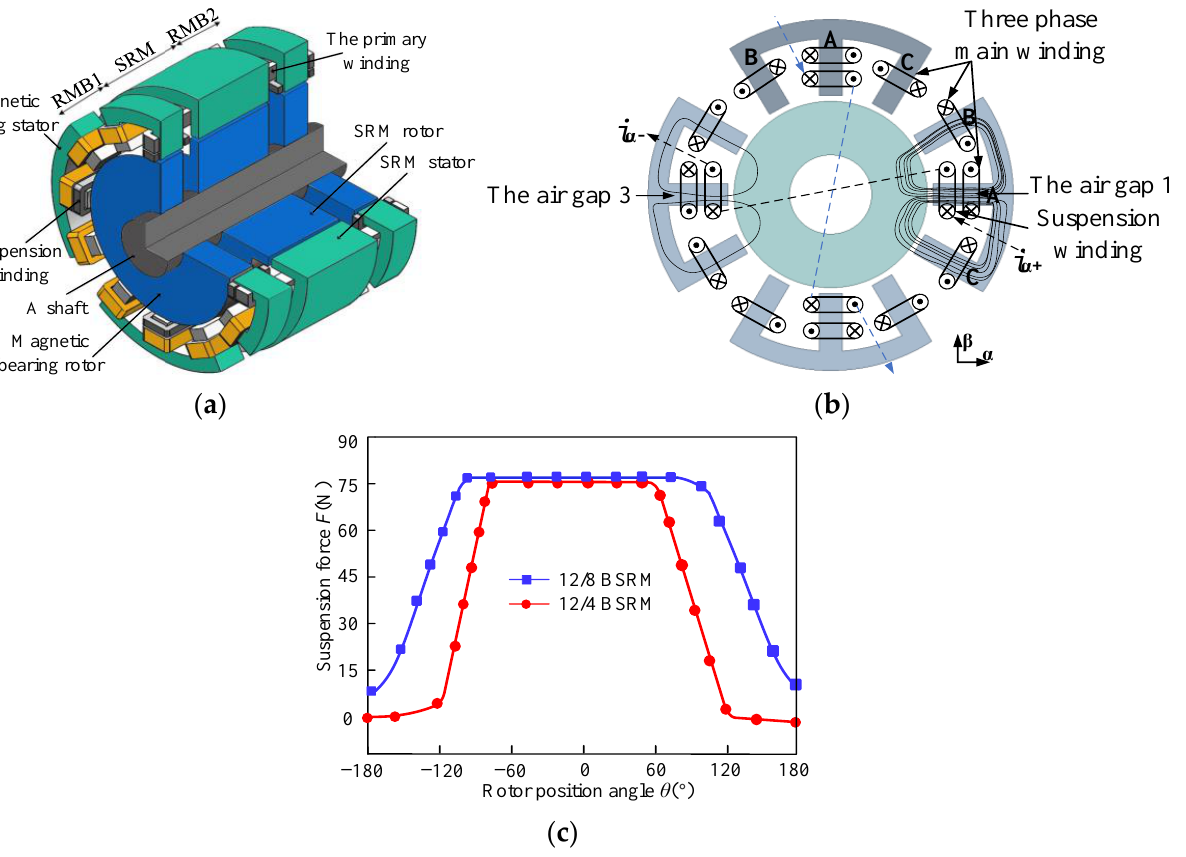
Figure 13. Composite structure BSRM: ( a ) Motor topology diagram; ( b ) Suspension force generation mechanism and magnetic force line distribution; and ( c ) Changing curve of F β with i α .